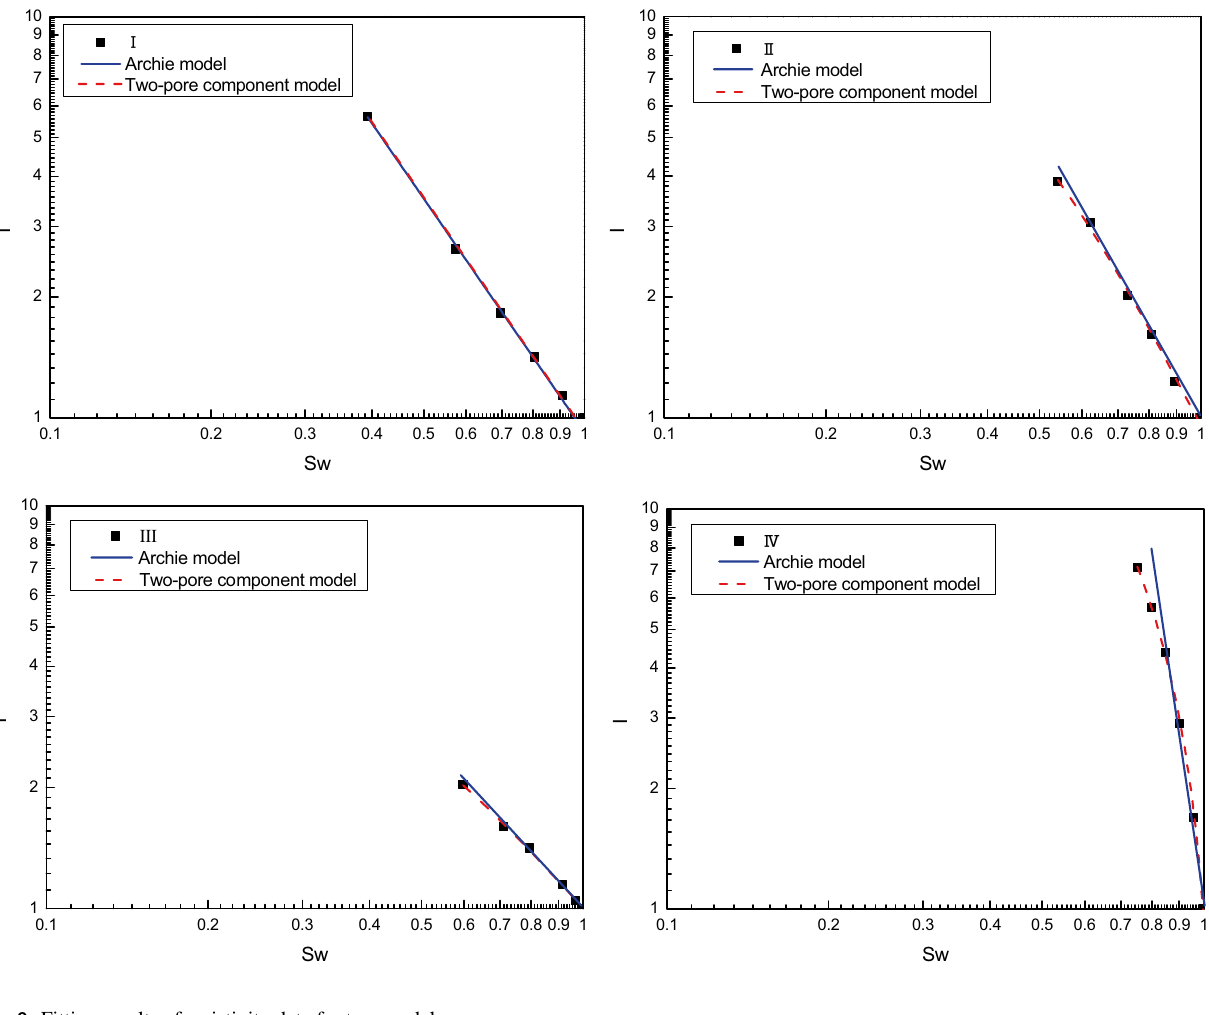
Fig. 9 Fitting results of resistivity data for two